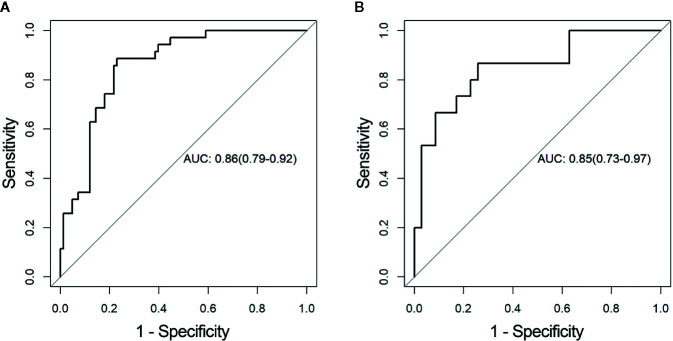
Receiver operating characteristic (ROC) curves of the radiomics signature in the (A) training and (B) validation cohorts, respectively. AUC, area under the receiver operating characteristic curve.